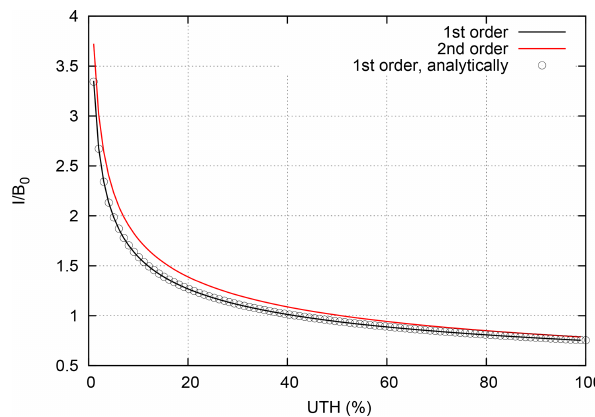
Figure 4. Normalised radiances, I/B 0 , resulting from numerical integration of Eqs. (22) and (23) for the first- (black) and second- order (red) retrievals. The curve consisting of circles is computed directly from the analytical formula (Eq. 18 of